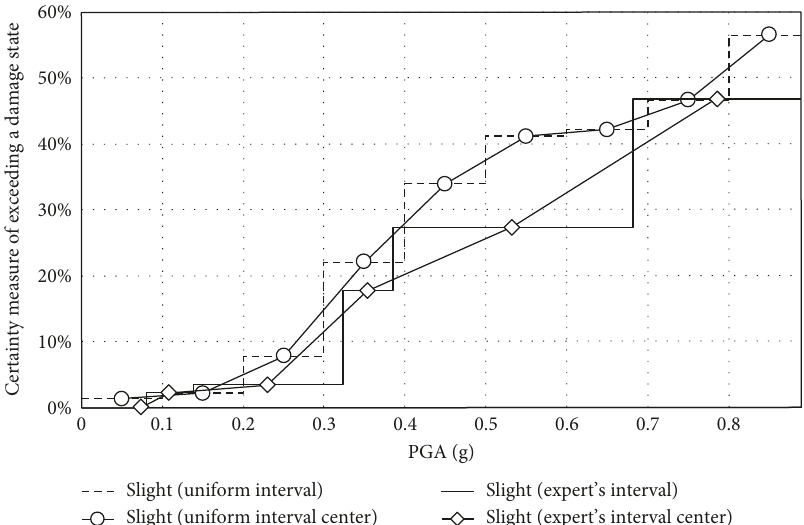
Figure 11: Comparison of the proposed fragility curves for Slight about the different interval selections with alternative formulation of the proposed fragility curves by using step function and connecting the necessity measure at the center of PGA